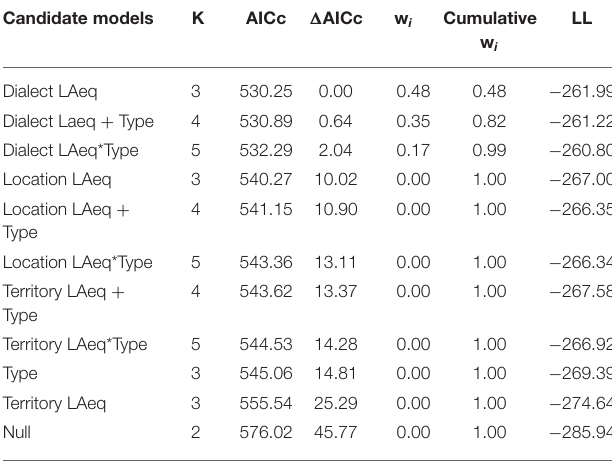
TABLE 3A | Nine Candidate models for the effects of noise (Dialect Regional Noise, Location Noise, and Territory Noise) and habitat type on vocal deviation.